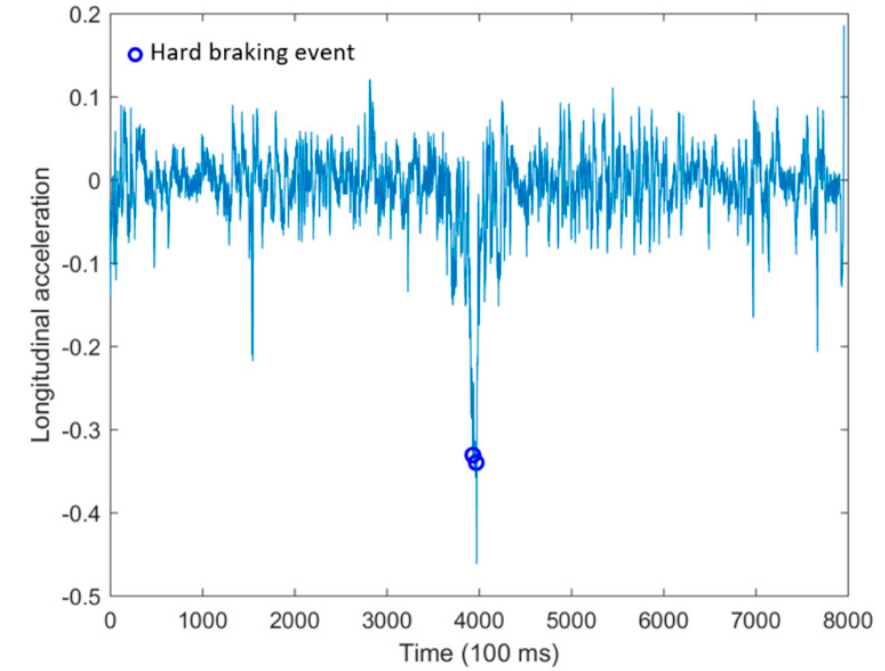
Figure 8. Situations when hard braking events are recognized.